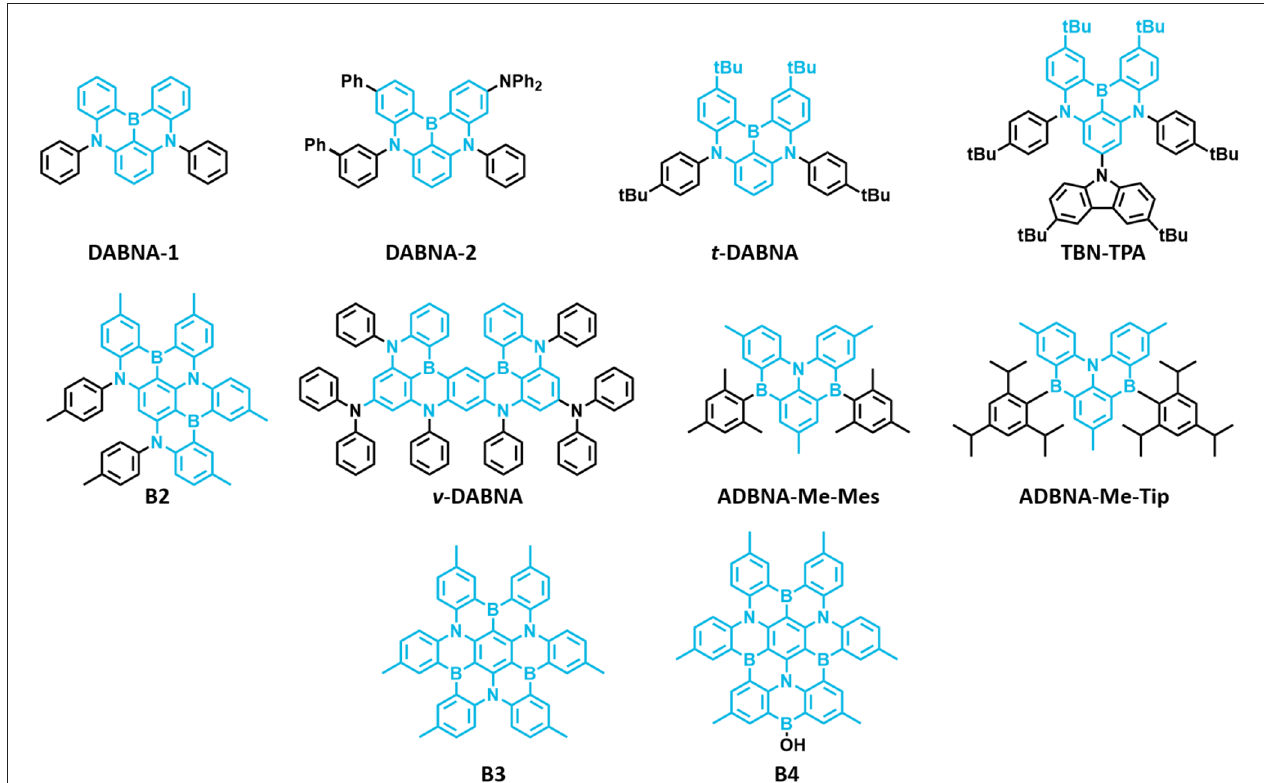
FIGURE 9 | Reported structures of multiple resonance (MR)-thermally activated delayed fluorescence (TADF)-based materials for blue TADF.